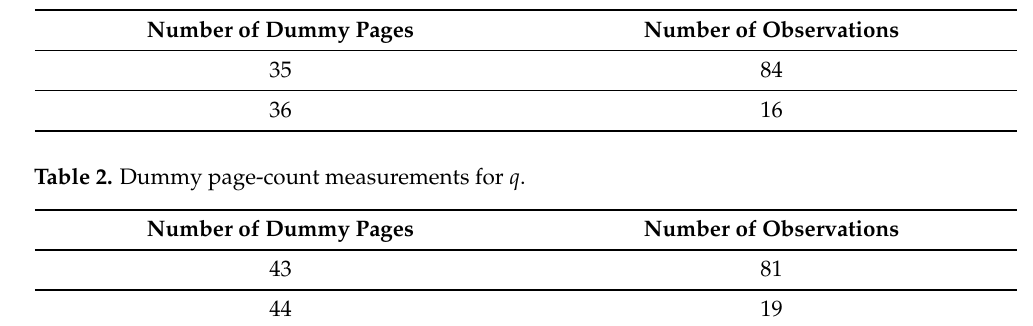
Table 1. Dummy page-count measurements for p .